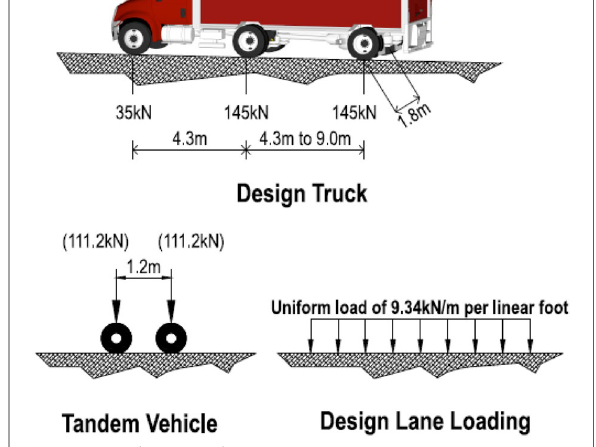
Fig. 7 HL-93 design truck.